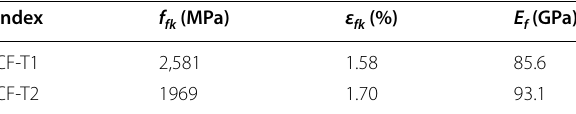
Table 8 Design parameters of C-FRCM in tension (ACI